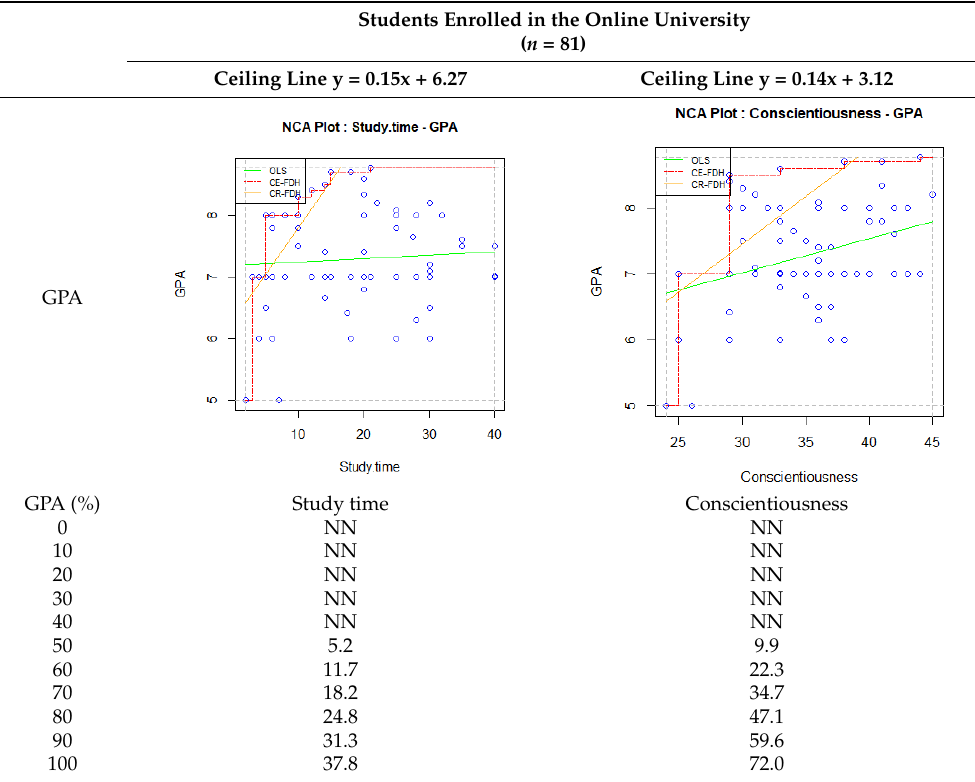
Table 3. Bottlenecks for study time and conscientiousness for students enrolled in the online university.